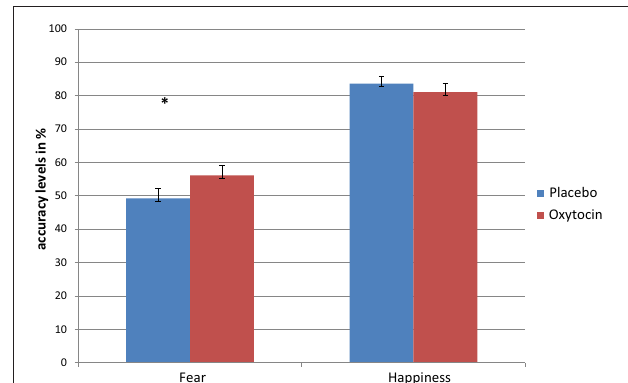
FIGURE 1 | Repeated measures analysis shows a significant interaction between treatment (OT/placebo) and emotional facial expression (fear/happiness), indicating a differential effect of OT and placebo treatments on recognition of fearful facial expressions, as opposed to happy expressions for all participants. Separate repeated ANOVA indicated significant treatment effect only for fear recognition ( ∗ ), but not for the recognition of happiness ( ∗ p < 0 .